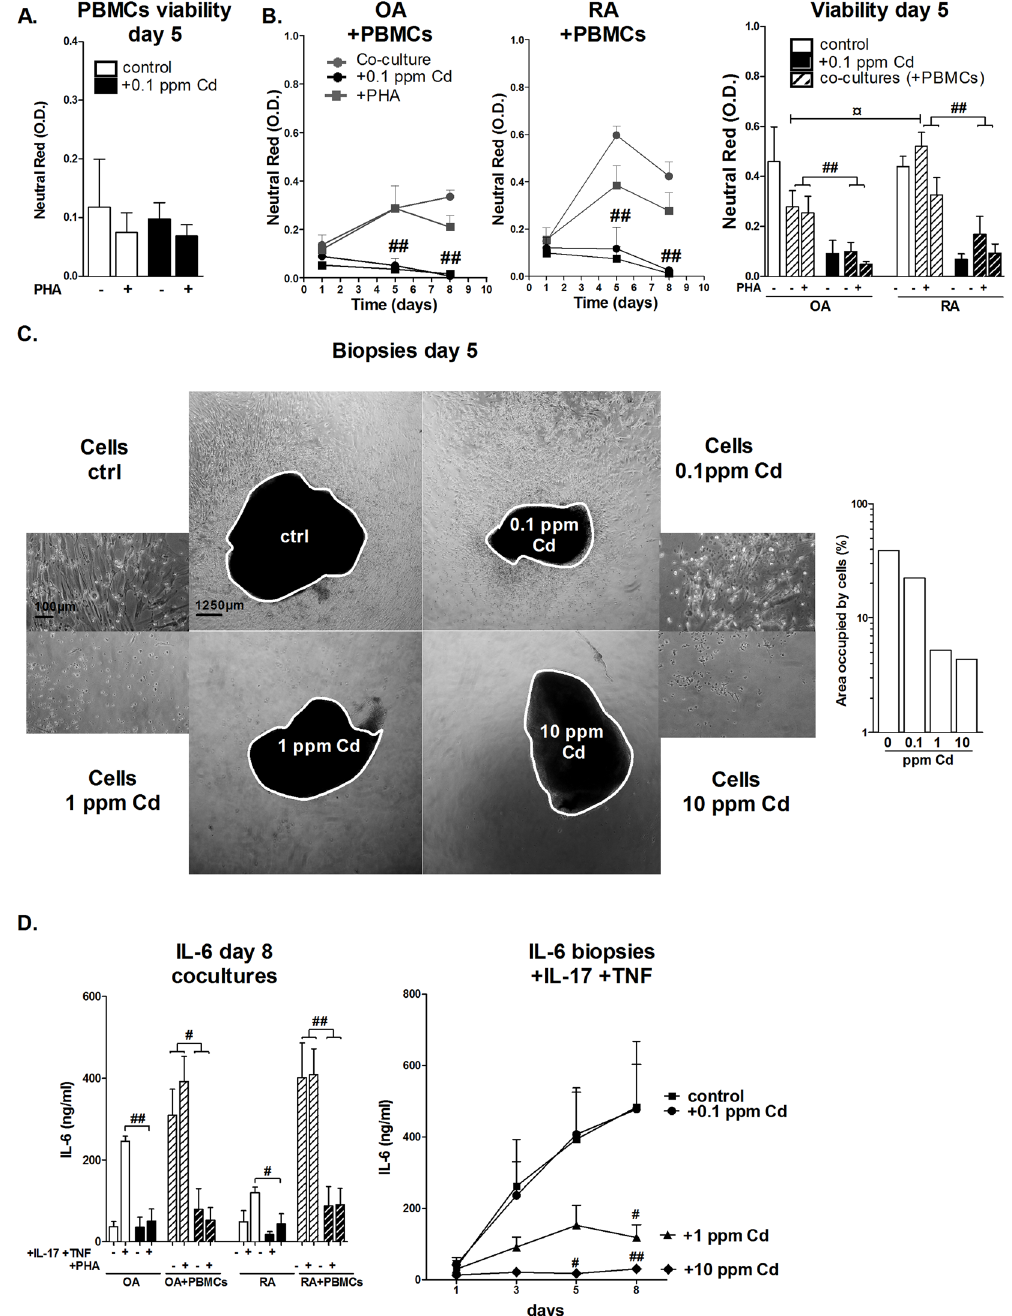
Figure 2. Low-dose Cd addition to RA synoviocyte cultures and biopsies, in inflammatory conditions, reduces cell viability and IL-6 production. ( A ) PBMCs viability assessed by neutral-red assay after exposure to Cd at 0.1 ppm. ( B ) OA and RA synoviocyte viability in co-culture with PBMCs assessed by neutral red assay at day 1, 5 and 8 after exposure to Cd. ( C ) Phase contrast photographs of biopsies (4x) and cells (10x) after exposure to IL-17 and TNF combination in the presence of increasing concentrations of Cd and quantification of the area occupied by the cells. ( D ) IL-6 production measured in supernatants of co-cultures after PHA activation or not and biopsies after exposure to IL-17 and TNF combination, with or without Cd addition at increasing concentrations. Data are the mean of at least three independent cell lines/biopsies (from three independent patients). Data are represented as mean ± SEM; Black lines: Cd exposure. * Indicates differences between non- inflammatory and inflammatory conditions, # differences due to Cd addition only in comparison to control; * /# p < 0.05, ** /## p <